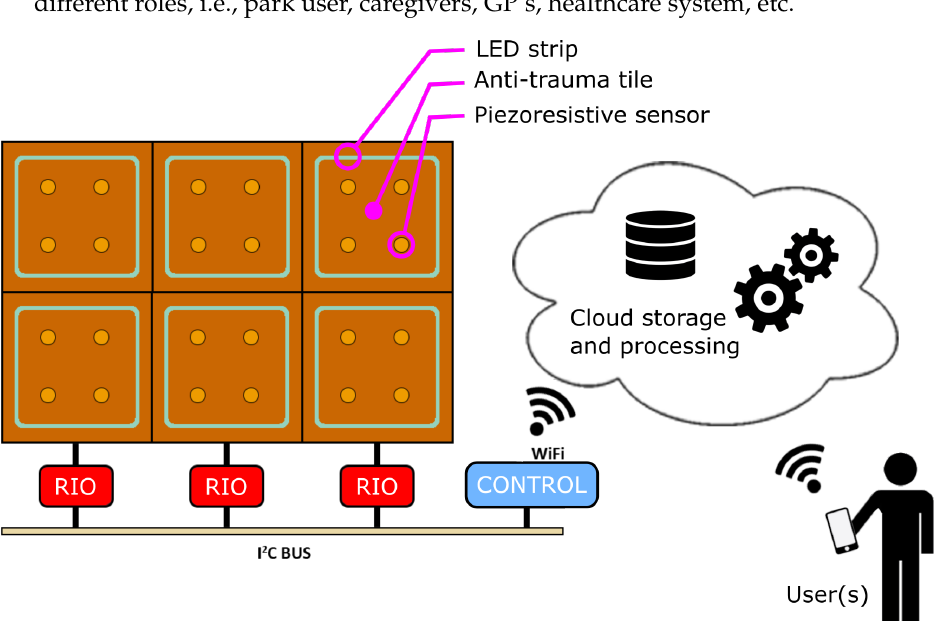
Figure 1. Schematic view of the smart flooring